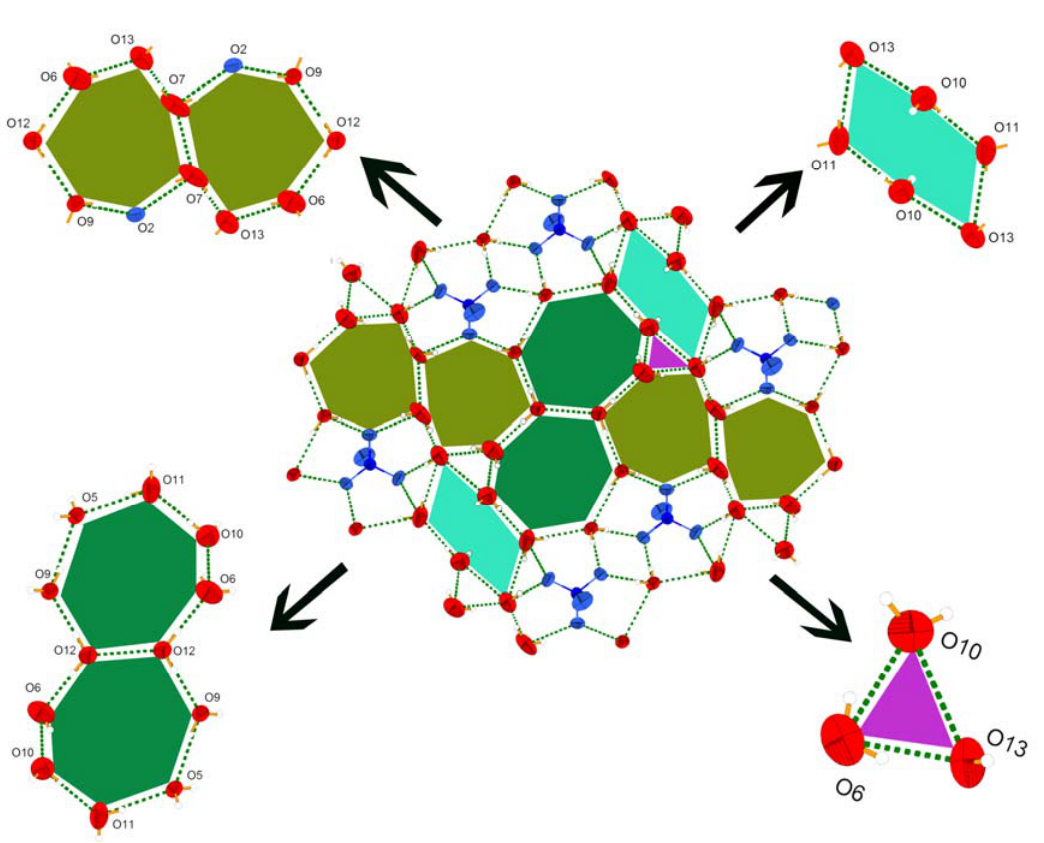
Figure 2. Perspective view of supramolecular water clusters morphology in complex 1